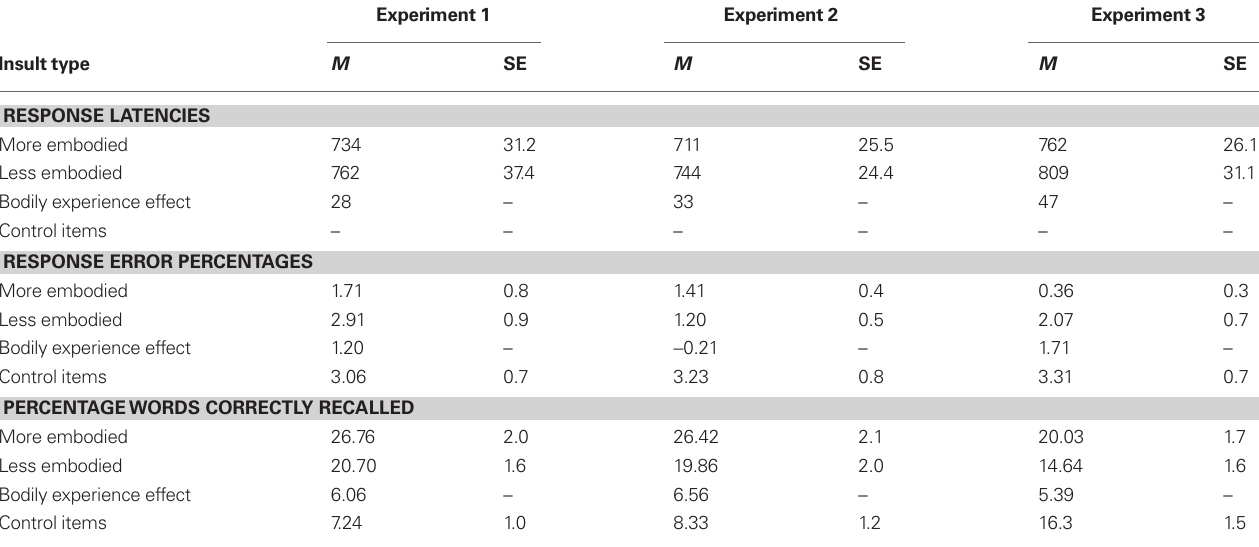
Table 2 | Mean response latencies (in ms) and standard errors, mean response error percentages and standard errors, and percentage words correctly recalled and standard errors for Experiments